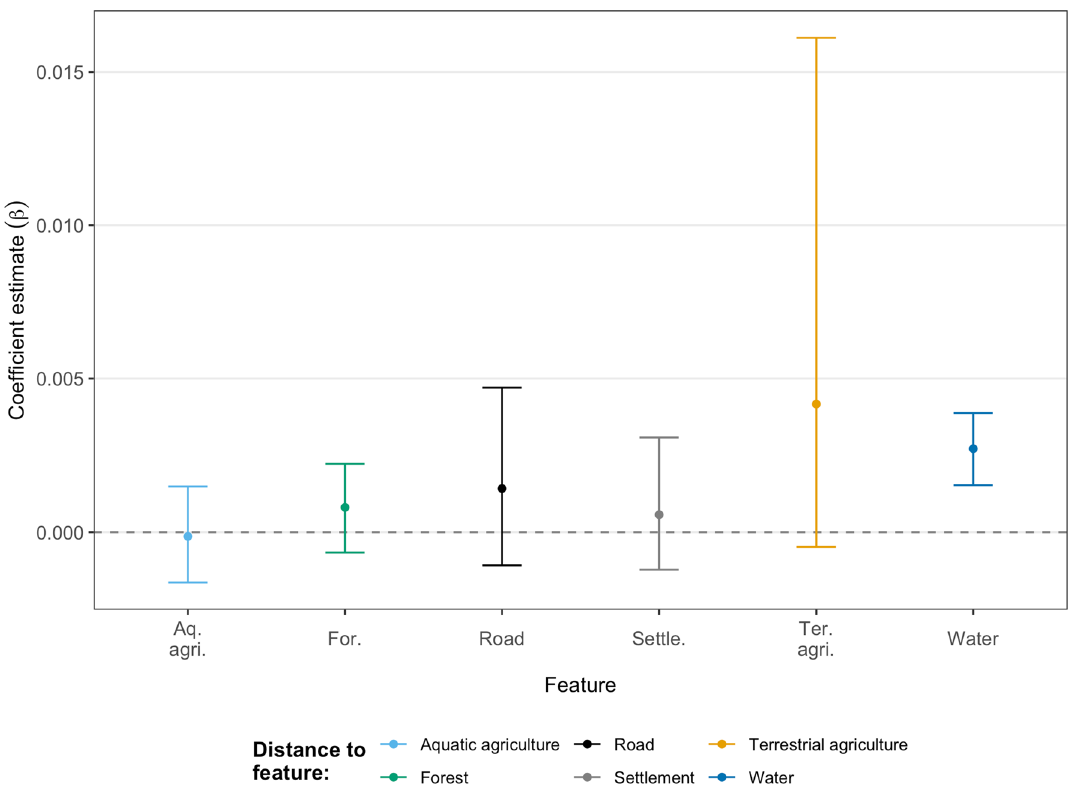
Figure 4. Habitat selection at the population level for all Burmese pythons ( Python bivittatus ) tracked in the agricultural matrix within the Sakaerat Biosphere Reserve, Nakhon Ratchasima, Thailand. Selection is based on distance to habitat features with positive estimates indicating positive association. Error bars indicate 95% credible intervals.